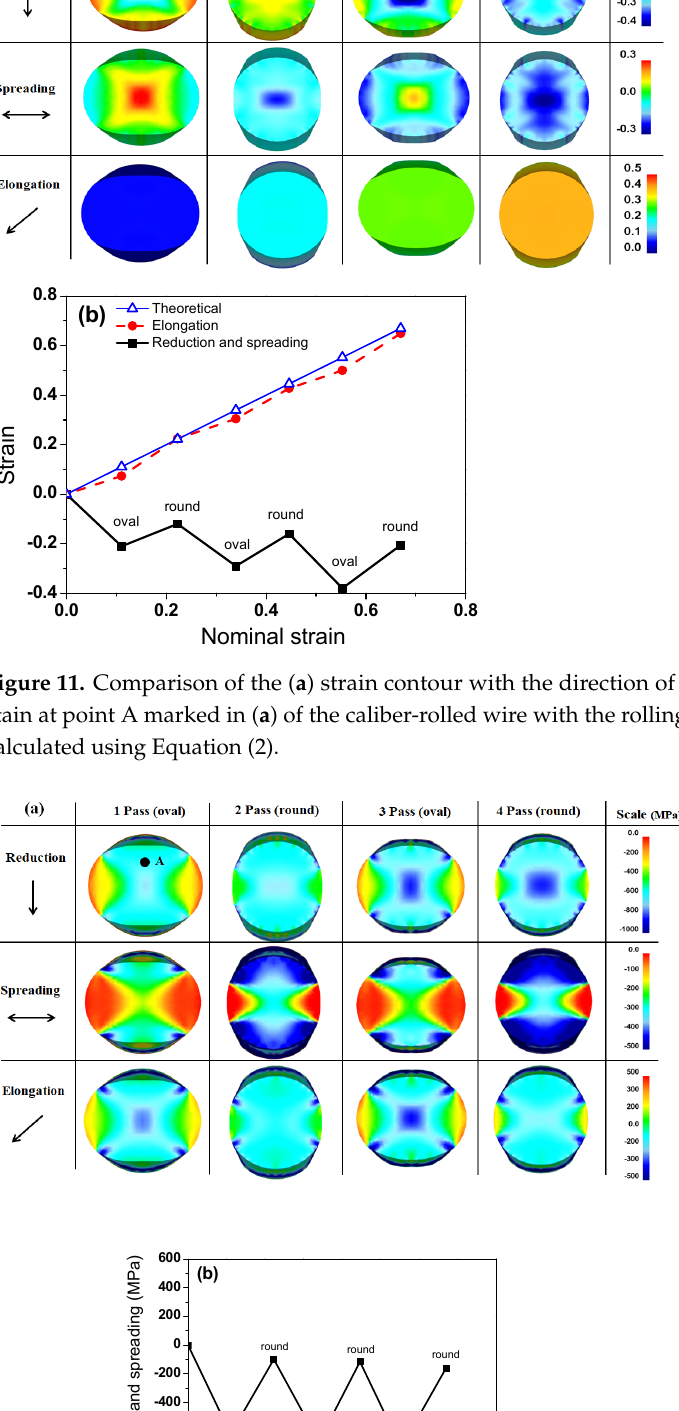
12 of 24 Figure 10. Comparison of the ( a ) contour maps of effective strain and ( b ) average effective strain of the drawn and caliber-rolled wires. Theoretical strain was obtained using Equation (2). During the conventional rolling process, the compressive stress imposed on the workpiece by the rolls deforms the workpiece in mainly three directions. In other words, the workpiece is deformed along the height, longitudinal, and width directions, and these phenomena are typically called reduction, elongation, and spreading, respectively [1]. Figure 11a shows a comparison of the strain contours against the deformation direc- tion of the wire with the rolling pass. The reduction and spreading contours were com- plex with the number of rolling passes owing to the change in the loading direction per pass during the caliber rolling process. The overall reduction and spreading strains ex- hibited negative values with the rolling step because the cross-sectional area was re- duced with the rolling steps. Accordingly, the elongation of the wire increased consist- ently with the rolling step, as shown in Figure 11b. The elongation of the caliber-rolled wire was similar to the nominal strain calculated using Equation (2). Based on the elon- gation variation in the wire with the rolling pass, it was also observed that spreading tended to occur during the oval pass and elongation primarily occurred during the round pass. Figure 11b shows the strain variation in the caliber-rolled wire along the re-